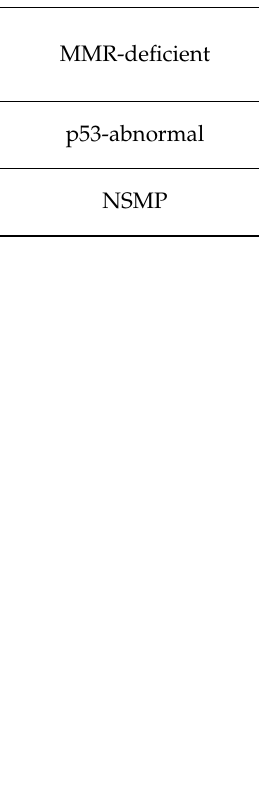
Table 2. Clinico-pathological features of the 4 molecular prognostic groups of endometrial